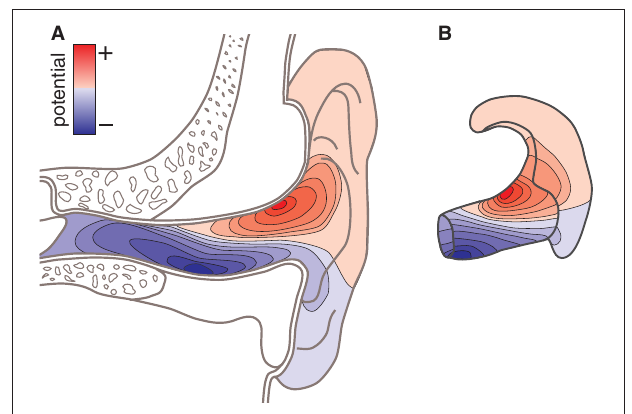
FIGURE 1 | Conceptual sketch showing the surface potential as topographic maps. (A) Topographic map on an anatomical cross-section of the outer ear. (B) Topographic map shown on an ear-EEG earpiece